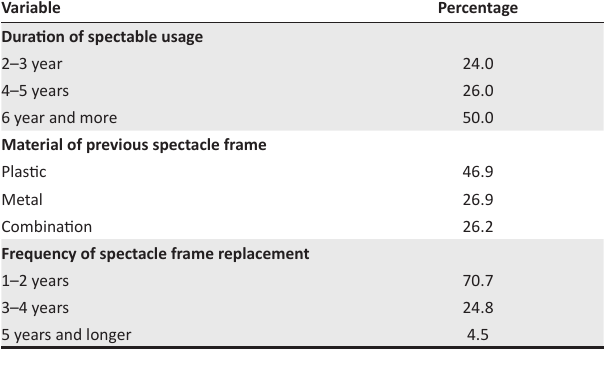
TABLE 1: Characteristics of spectacle usage among